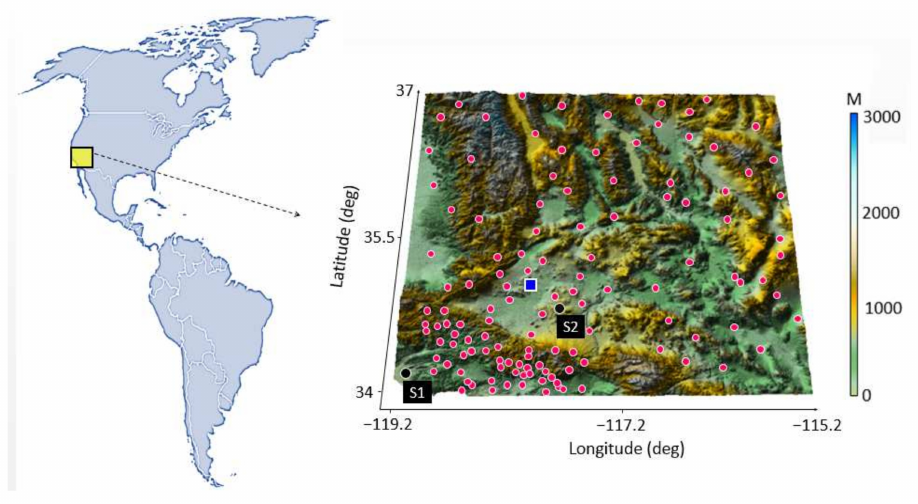
Figure 3. Distribution of GNSS stations and topography of the area. The blue square shows the location of the radiosonde station, red circles show the GNSS stations, and black circles show the position of the stations where precipitation downscaling took